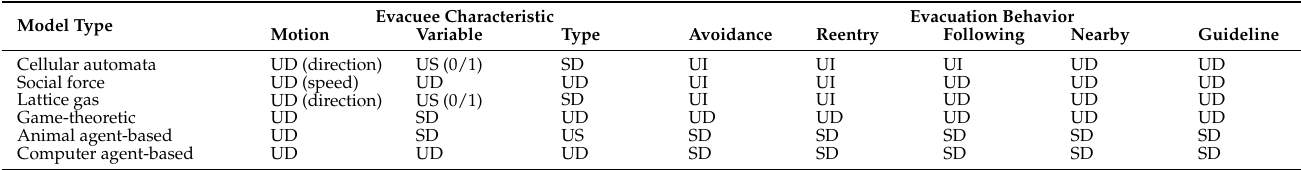
Table 2. Functional analysis of evacuation